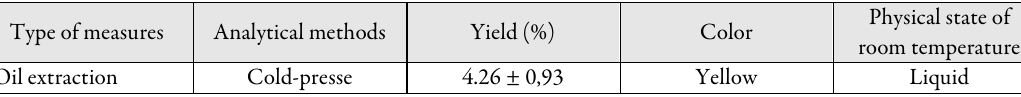
Table 1. The oil extraction yield of OFI seeds Type of measures